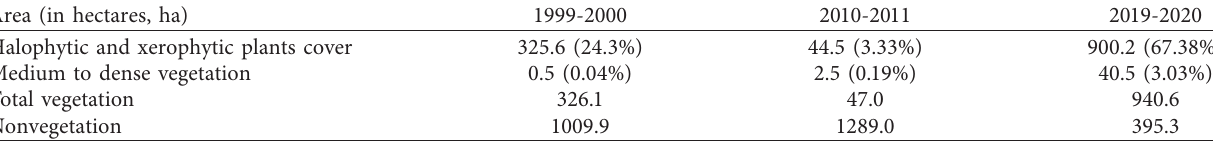
Table 2: NDVI-based land cover/vegetation cover area (ha) and percentage for comparison years.